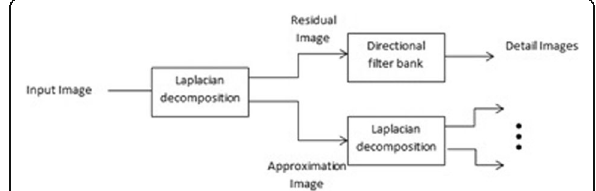
Fig. 1 Contourlet transform